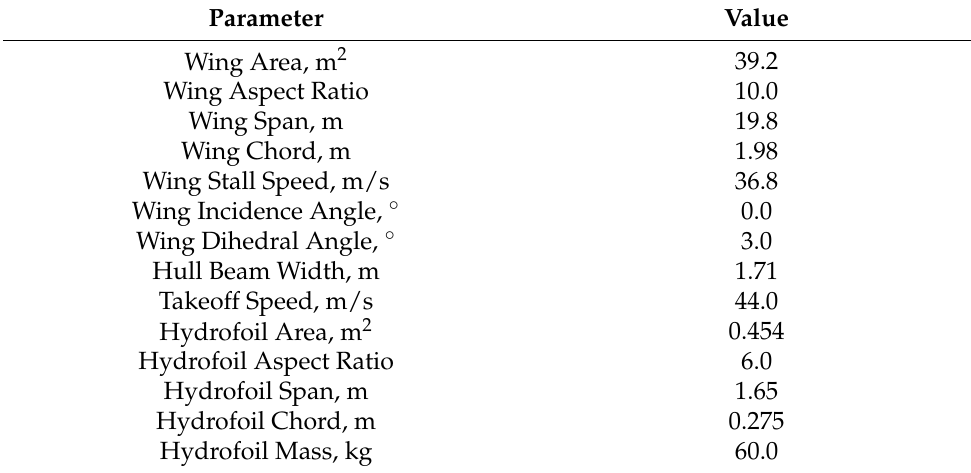
Table 3. Aircraft and hydrofoil